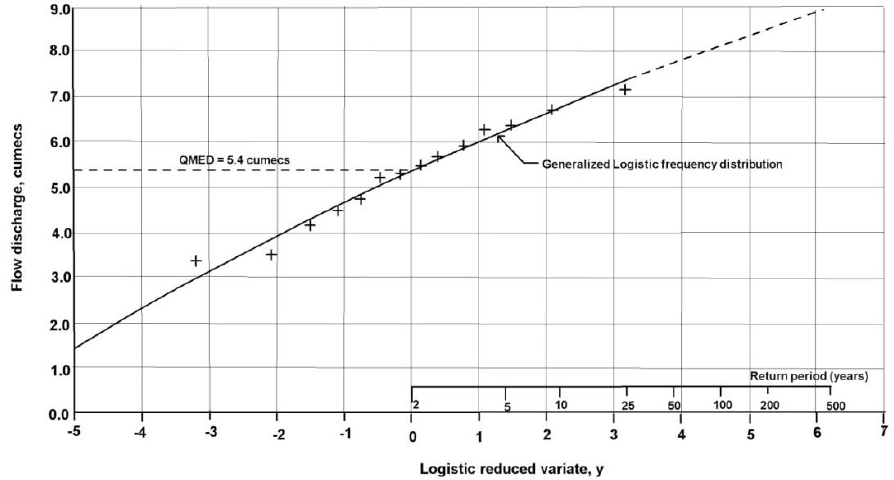
Figure 2. Flood frequency curve at Coull, Tarland derived using single site